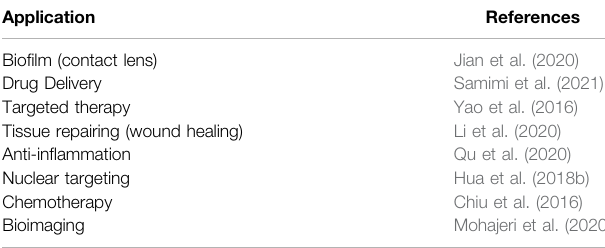
TABLE 1 | Some clinical applications of CQDs.